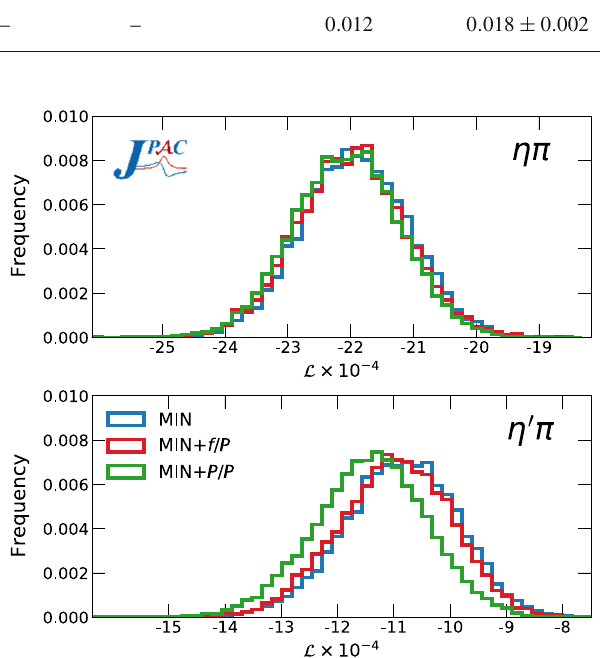
Fig. 11 ENLL L MCR distributions for the 10 4 bootstrap fits with the three models to the MCR distributions for ηπ (upper) and η (cid:2) π (lower) channels